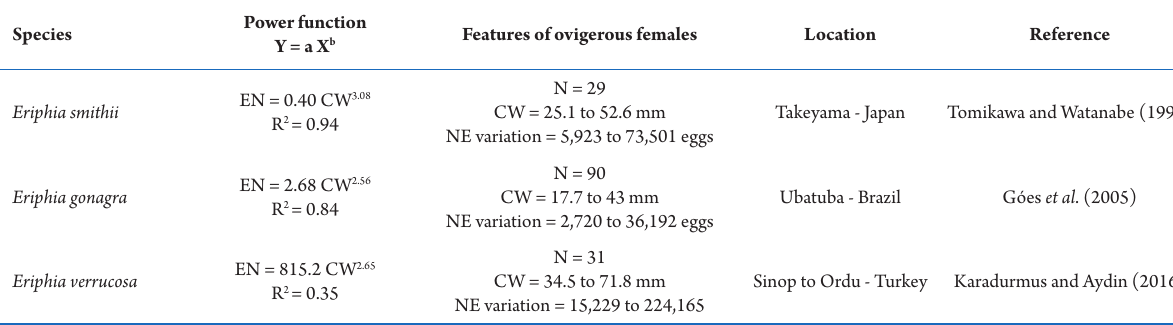
Table 1. Reported fecundities for species of the genus Eriphia Latreille,